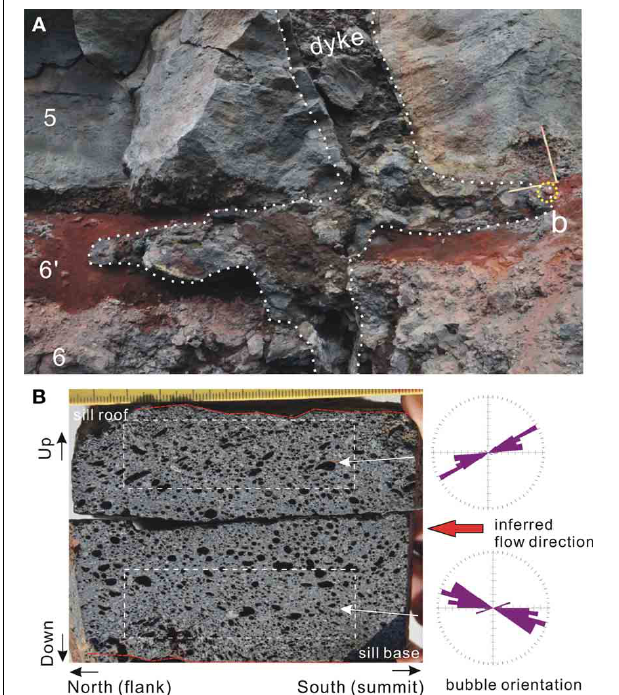
FIGURE 9 | View of the sill of the feeder system cropping out along the southern wall of the 1809 crater A (outcrop A–S). (A) The close up view of a sill developing in Unit 6. Outline of the dyke and sill is shown by white dotted lines. Yellow circle shows the position of the sample for the analysis of preferred orientation of bubbles. (B) The vertical cross section of the sill along the strike of the feeder system. Distributions of the bubble elongation in upper and lower part of the section are shown on right. Boxes with dashed line show the area for the bubble